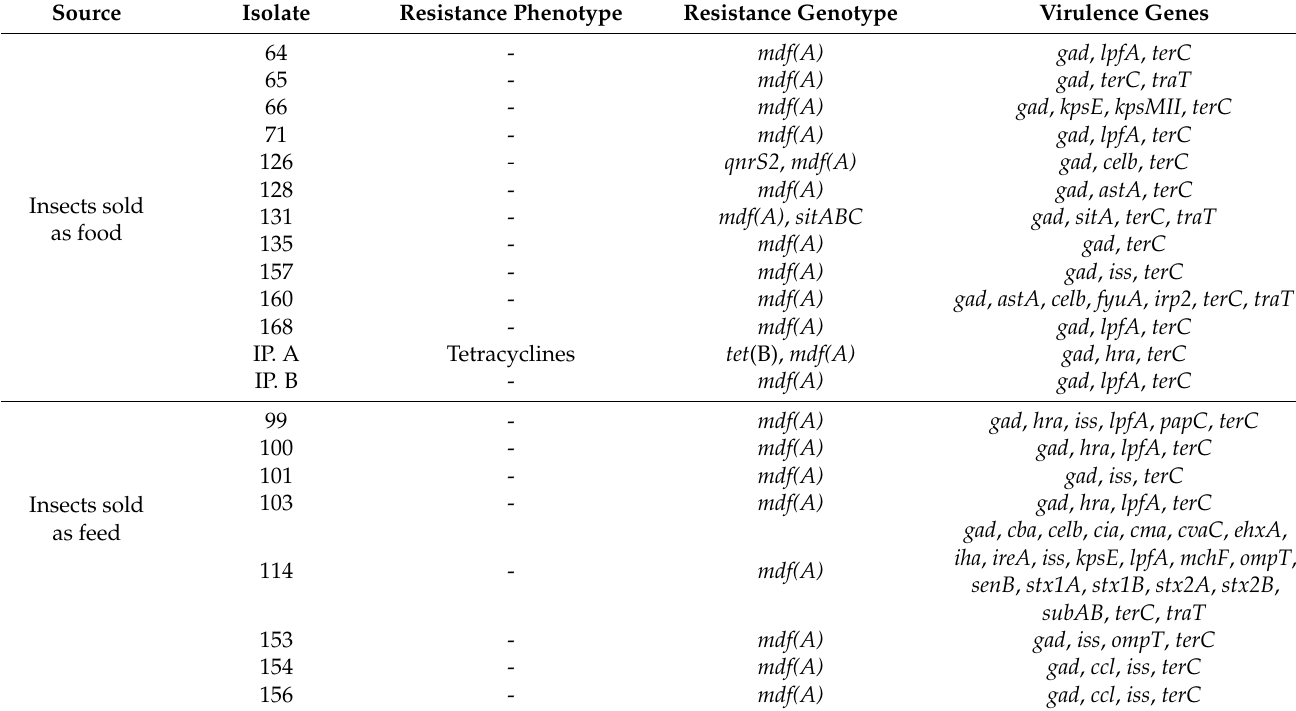
Table 1. Antimicrobial resistance phenotypes, antimicrobial resistance genes, and virulence-associated genes of 21 E. coli isolates. Source